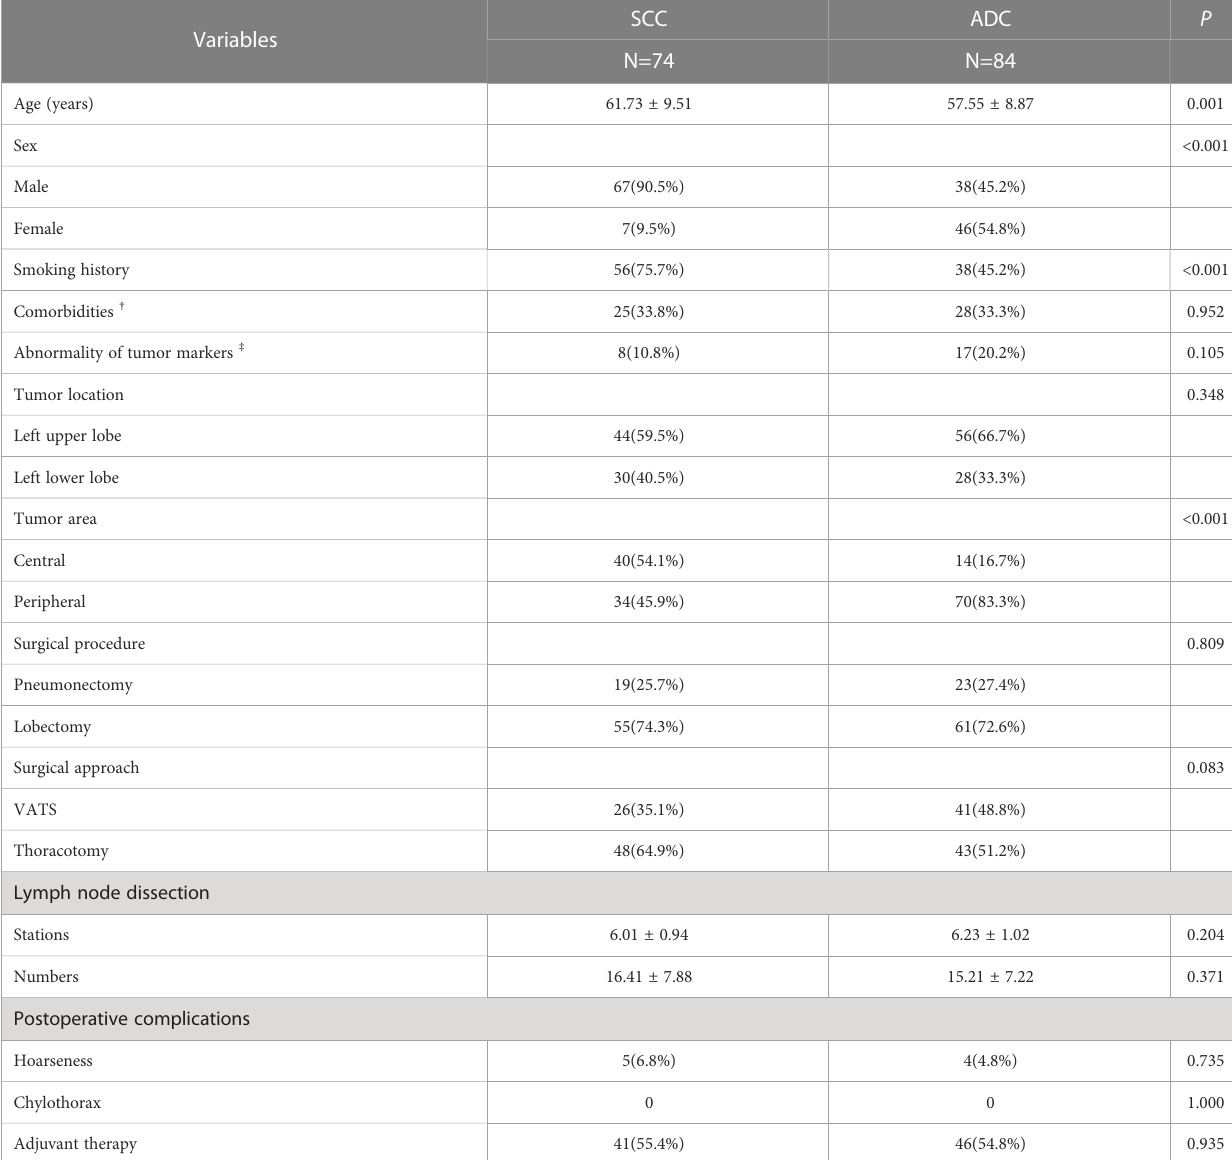
TABLE 1 Clinical characteristics of patients in the squamous cell carcinoma and adenocarcinoma